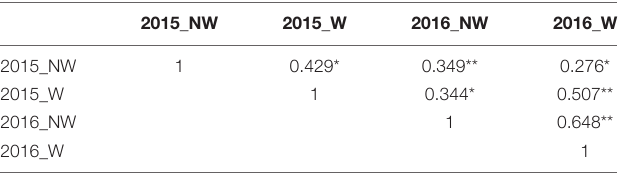
TABLE 2 | Spearman’s rank correlation coefficients for Disease Severity Index (DSI) between years and